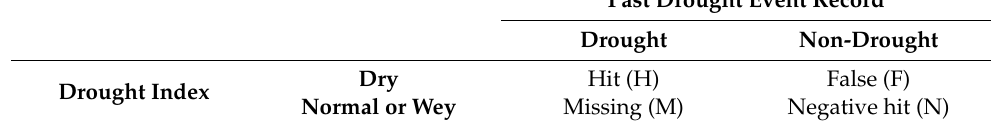
Table 2. ROC Model.